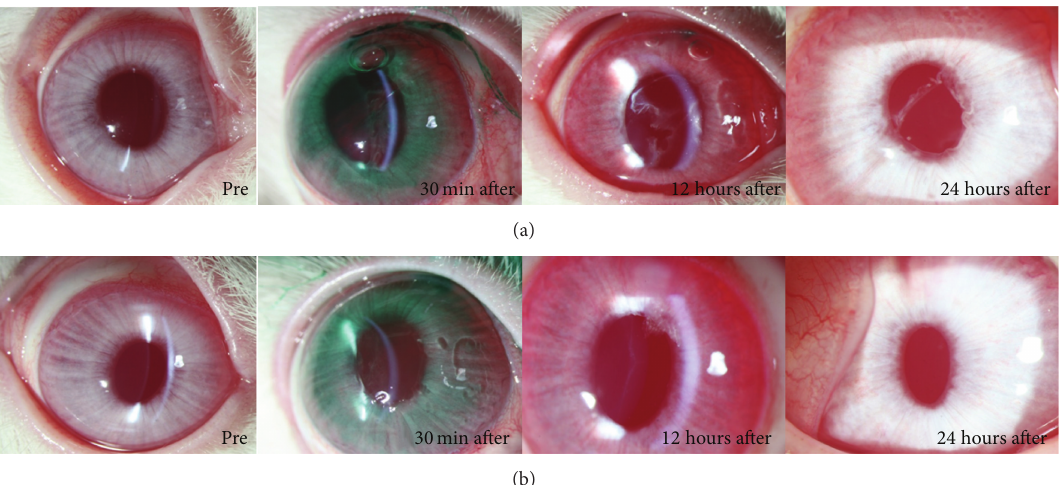
Figure 3: Compared to the ICG exposure time, fibrous membrane formation was more prominent in the right eye (a) of Rabbit Number Two that was exposed to ICG for a longer time than left eye